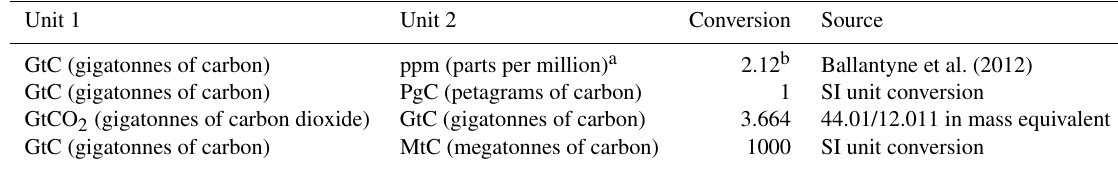
Table 1. Factors used to convert carbon in various units (by convention, unit 1 = unit 2 ·